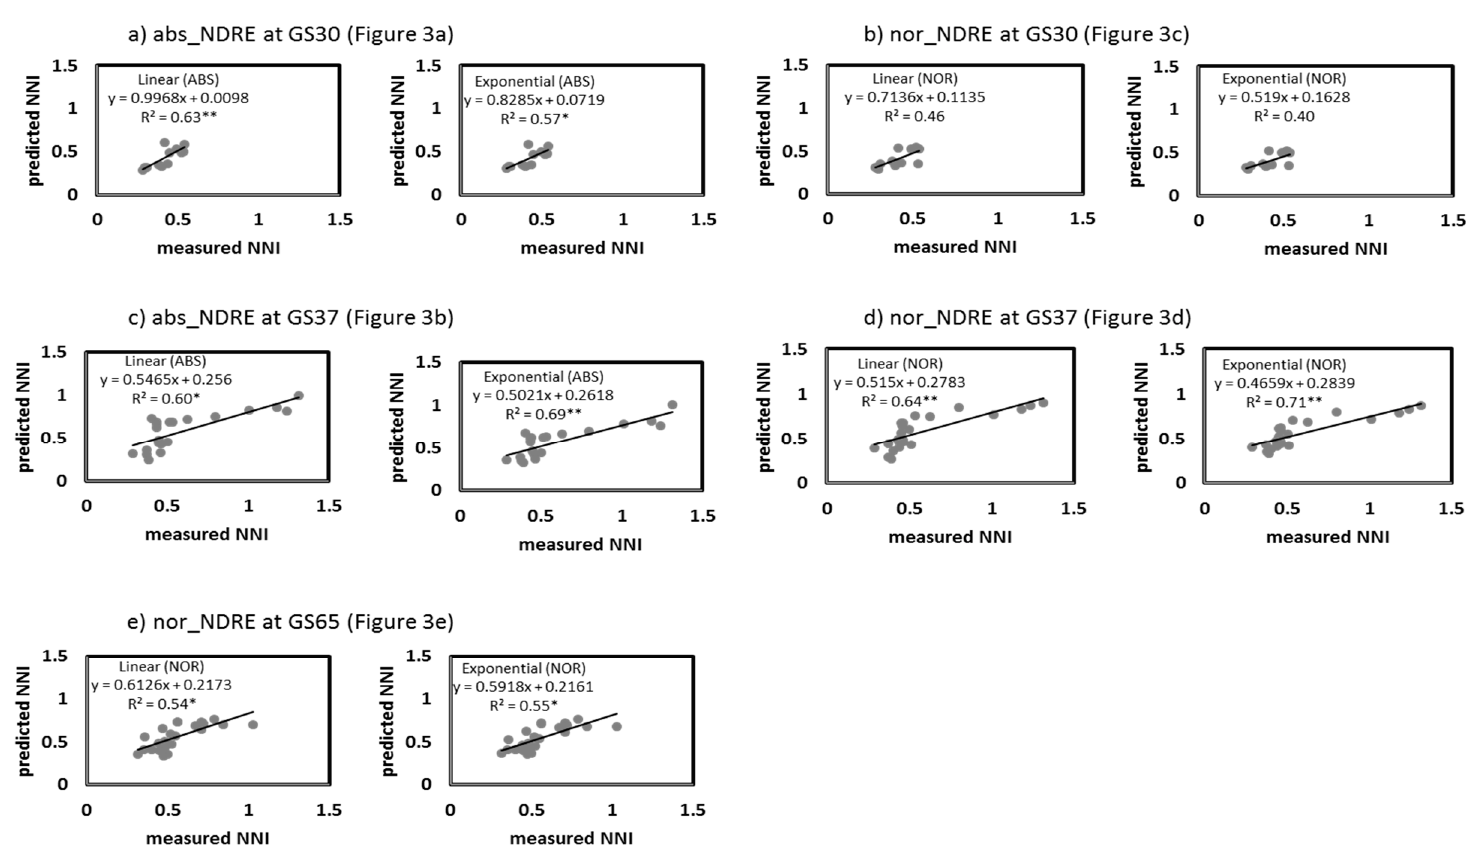
Figure 8. Relationships between the predicted NNI (Nitrogen Nutritional Index) values (from abs_NDRE at GS30 ( a ), nor_NDRE at GS30 ( b ), abs_NDRE at GS37( c ), nor_NDRE at GS37 ( d ), and nor_NDRE at GS65 ( e ) values in the growing stage-specific models) and the measured NNI values from 25% of the samples. *, ** Significant at 0.05 and 0.01 probability levels, respectively. abs, absolute values; nor, normalized values; NDRE, Normalized Difference Red Edge Index.